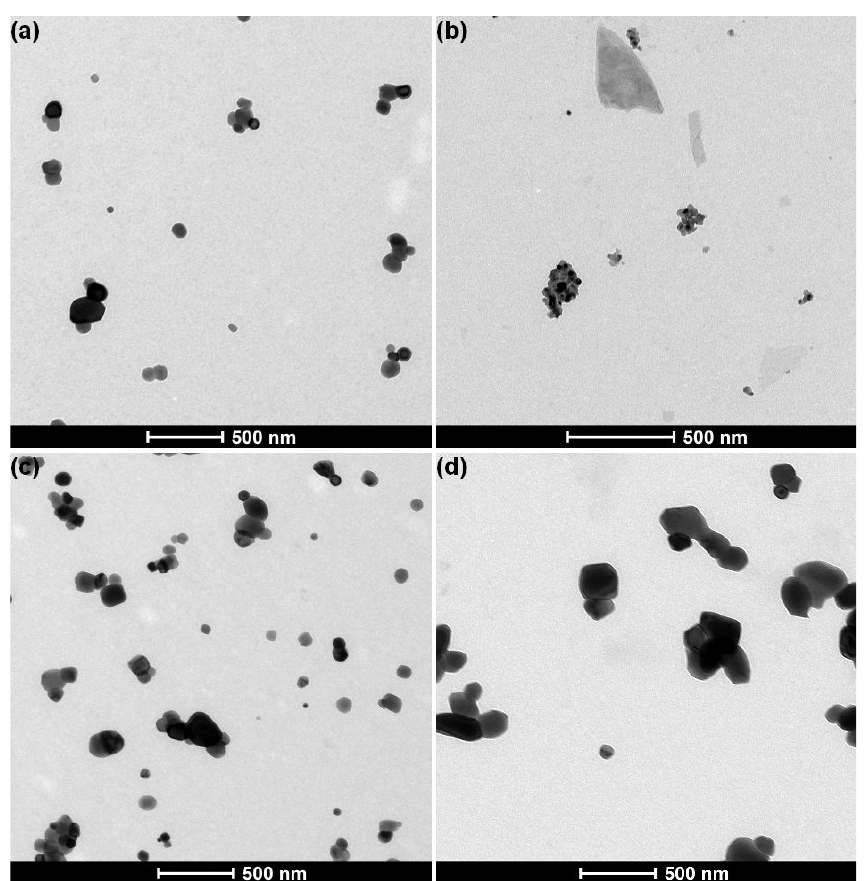
Figure 2. Representative transmission electron microscopy (TEM) images of E171 materials with ( a ) anatase TiO 2 obtained from webshops (image of material E171-06, prepared using protocol P6), ( b ) pearlescent pigment Type I, obtained from webshops (image of material E171-01, prepared using protocol P1), ( c ) anatase TiO 2 from business operators (image of material E171-B, prepared using protocol P6), and ( d ) rutile TiO 2 (image of material E171-F, prepared using protocol P6) from business